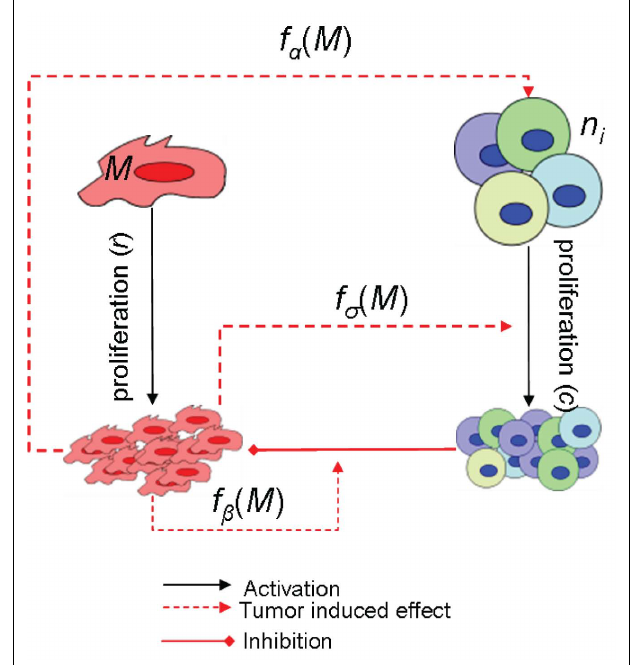
FIGURE 1 |The interactions betweenTag-expressing cells ( M ) andT CD8 s and the parameters modeling the dynamics are depicted. Edges represent activating (black arrows), inhibiting (blunt segments), and tumor-induced (red arrows) interactions, f represents a Michaelis–Menten